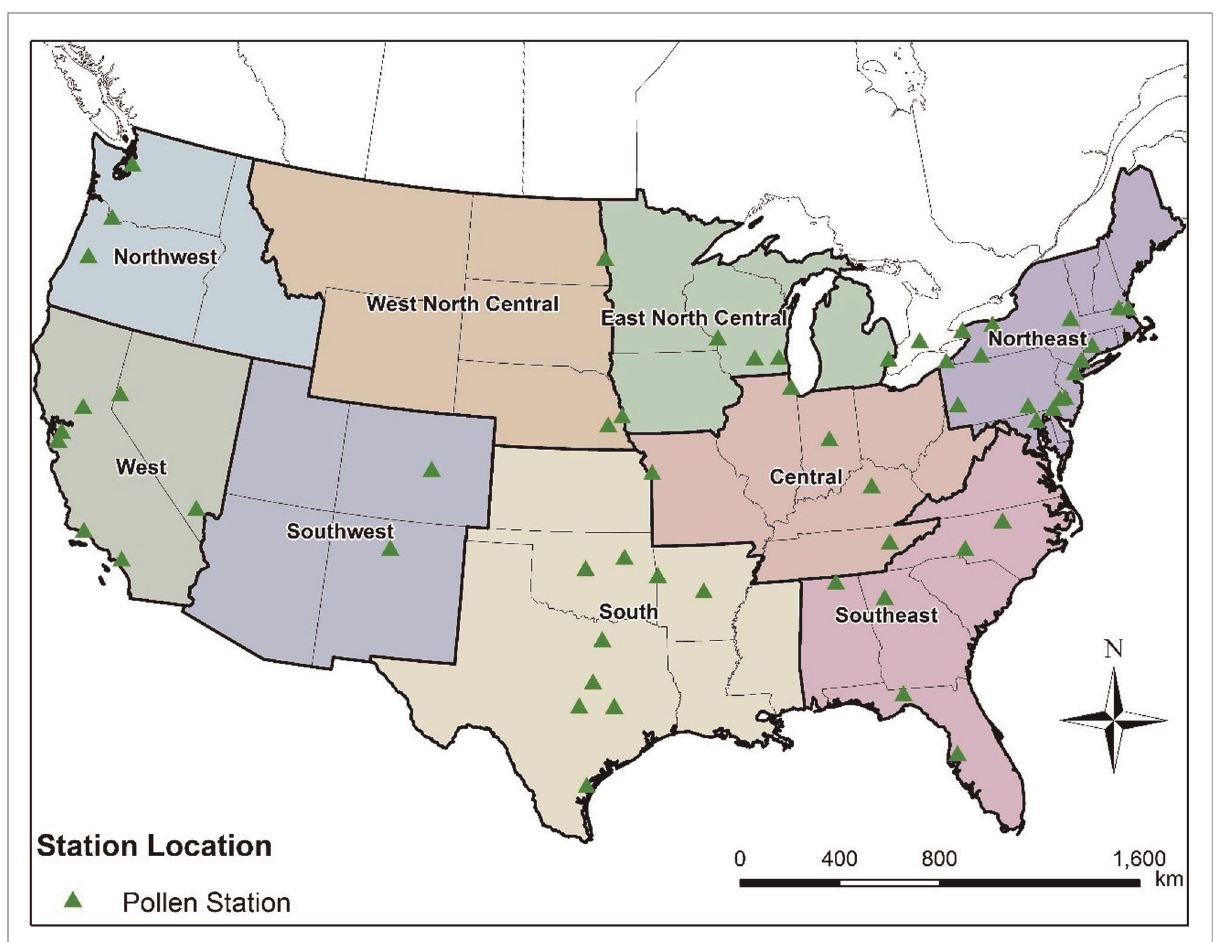
FIGURE 1 Distribution of the 58 studied pollen stations across the nine climate regions in the contiguous United